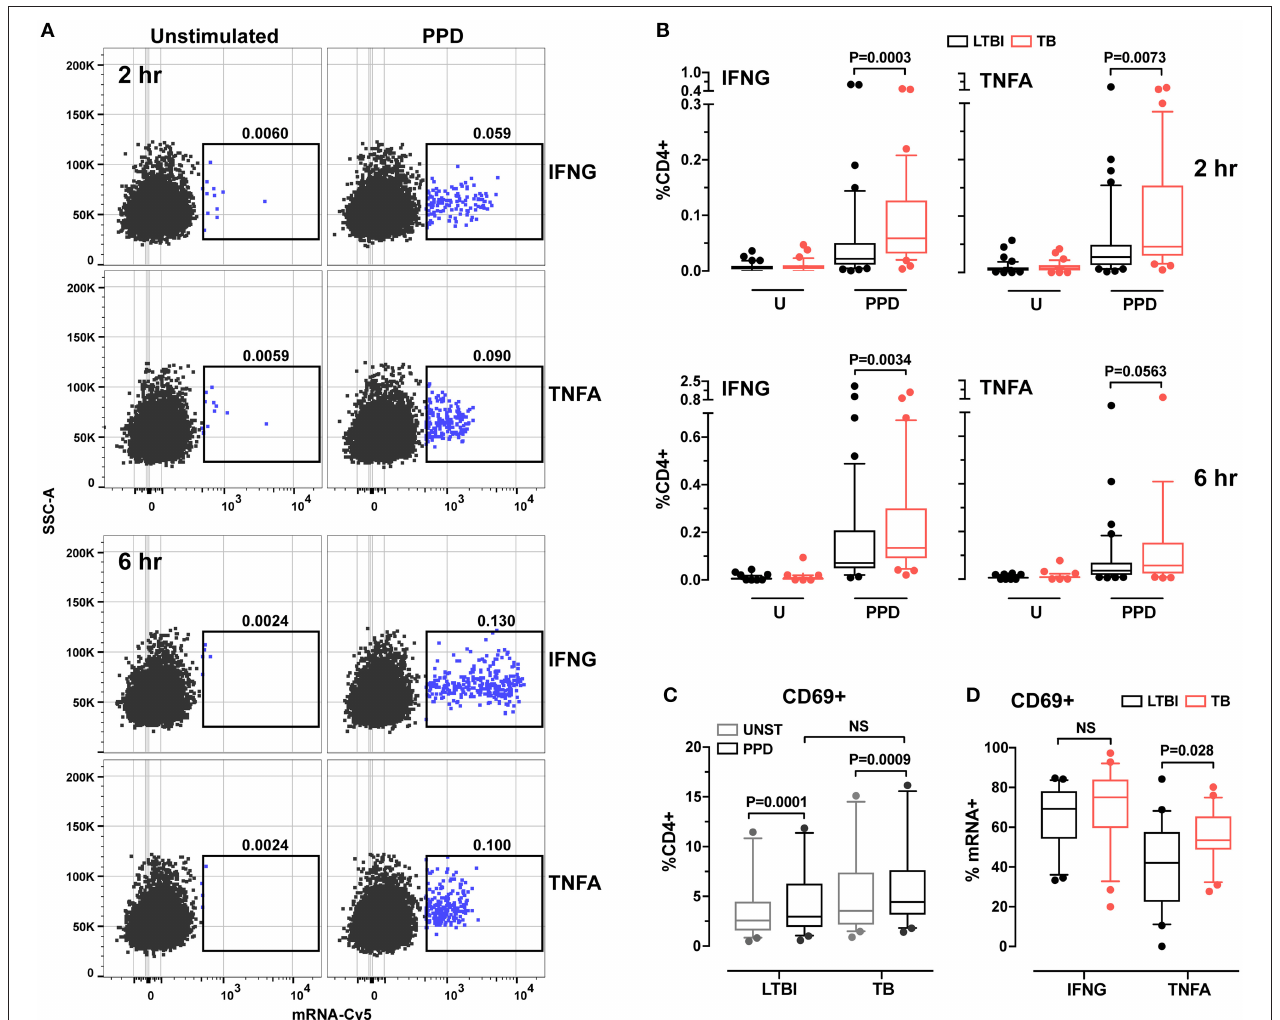
FIGURE 1 | Analysis of cytokine expression and cell activation in CD4 + T cells from LTBI and active TB donors. (A) Representative dot plots of IFNG and TNFA cytokine expression in CD4 + T cells after 2 and 6h in vitro stimulation. PBMC were stimulated for 2 and 6h with PPD or left unstimulated. After stimulation samples were stained for surface markers and hybridized with IFNG or TNFA mRNA probes. Frequencies of CD4 + cytokine mRNA + cells are reported above each gate. (B) Cytokine expression in CD4 + cells. Data are expressed as the frequencies of CD4 + T cells expressing IFNG or TNFA mRNA at each time point. LTBI n = 47, TB n = 34. (C) CD69 expression in unstimulated and PPD stimulated CD4 + T cells for 2h. Data were expressed as frequency of CD4 + T cells. LTBI n = 24, TB n = 22. Gating strategy is described in Supplementary Figure 1C (upper panel). Outliers above 20% (one per group) were removed to allow for better